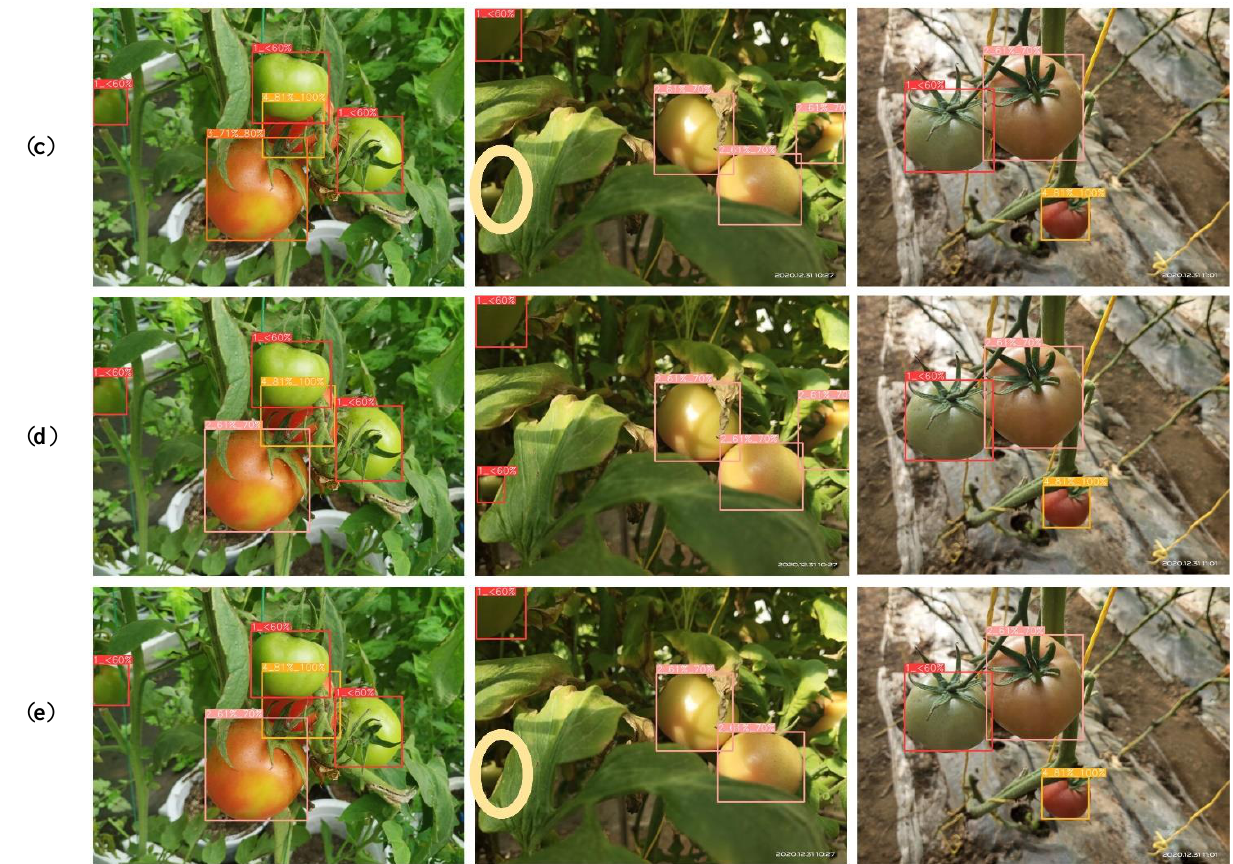
Figure 11. The predicted performance of four models. ( a ) Manually marked initial image; ( b ) YOLOv3 model; ( c ) YOLOv3-MobileNetV1 model; ( d ) SE-YOLOv3-MobileNetV1; ( e ) YOLOv5.